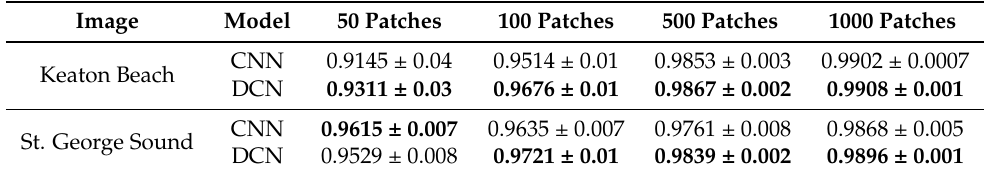
Table 3. Accuracies obtained by our transfer learning approach utilizing different number of samples from new locations. Five experiments are performed for each sample size. The table shows the results as mean ± std. Best results are highlighted in bold.